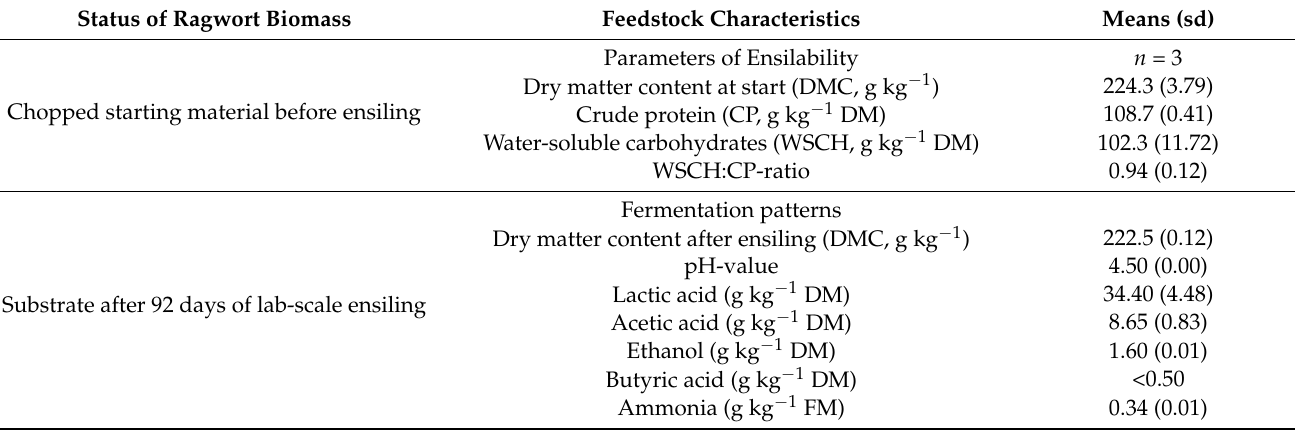
Table 1. Ensiling characteristics of biomass from landscape conservation growths dominated by common ragwort ( J. vulgaris ).